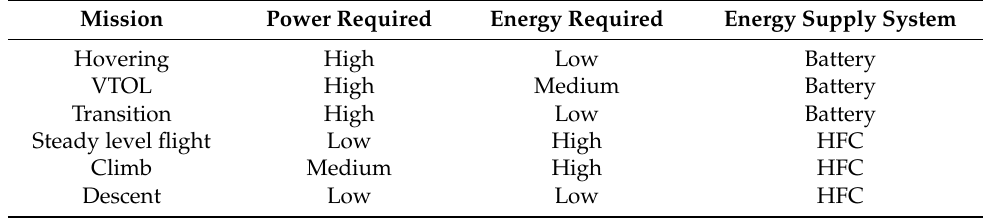
Table 2. Multi-mode UAV operation